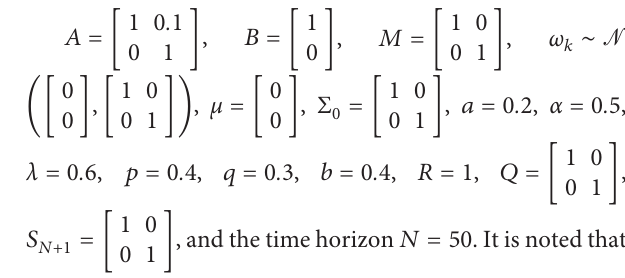
Figure 2: The pseudocode of obtaining the control